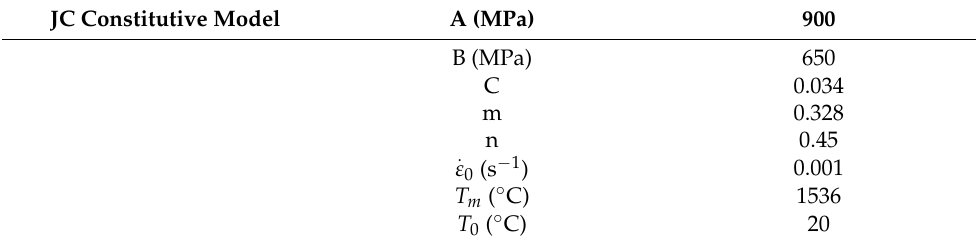
Table 2. Johnson–Cook model coefficient for AISI 4140 [14,15].